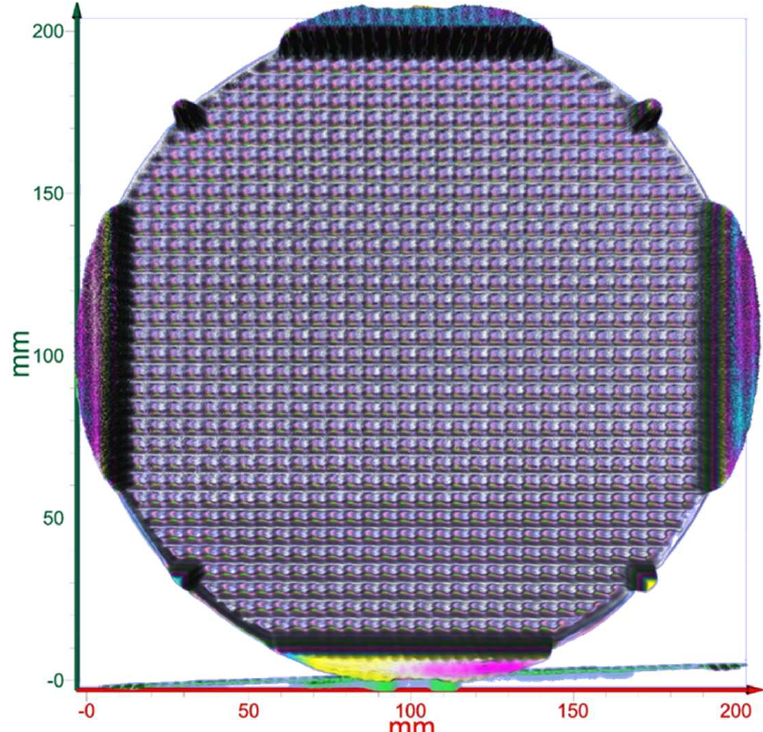
Figure 4. T-ray image of a 200 mm whole wafer with die patterns.